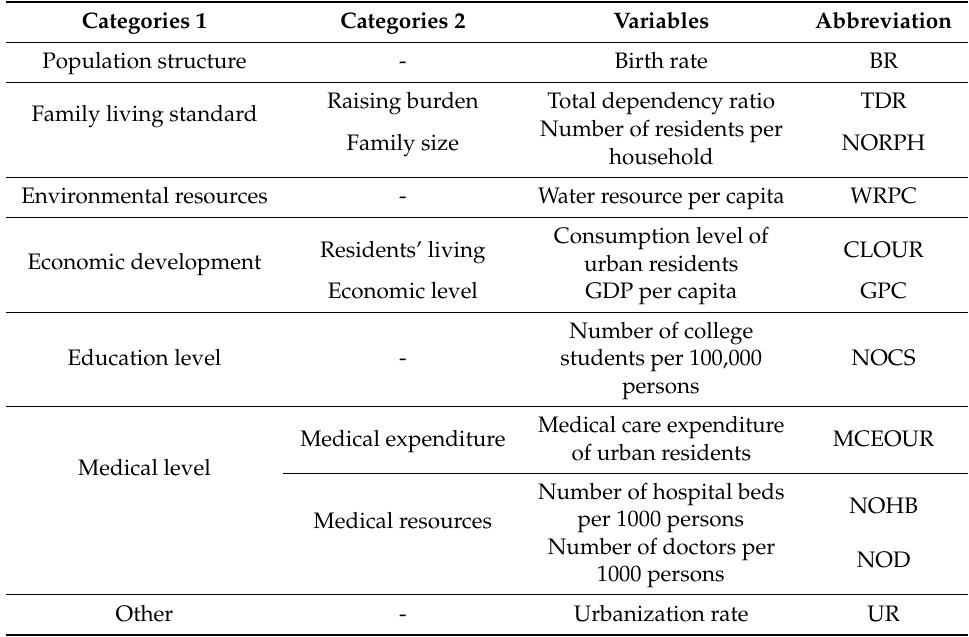
Table 1. Social and environmental factors in the